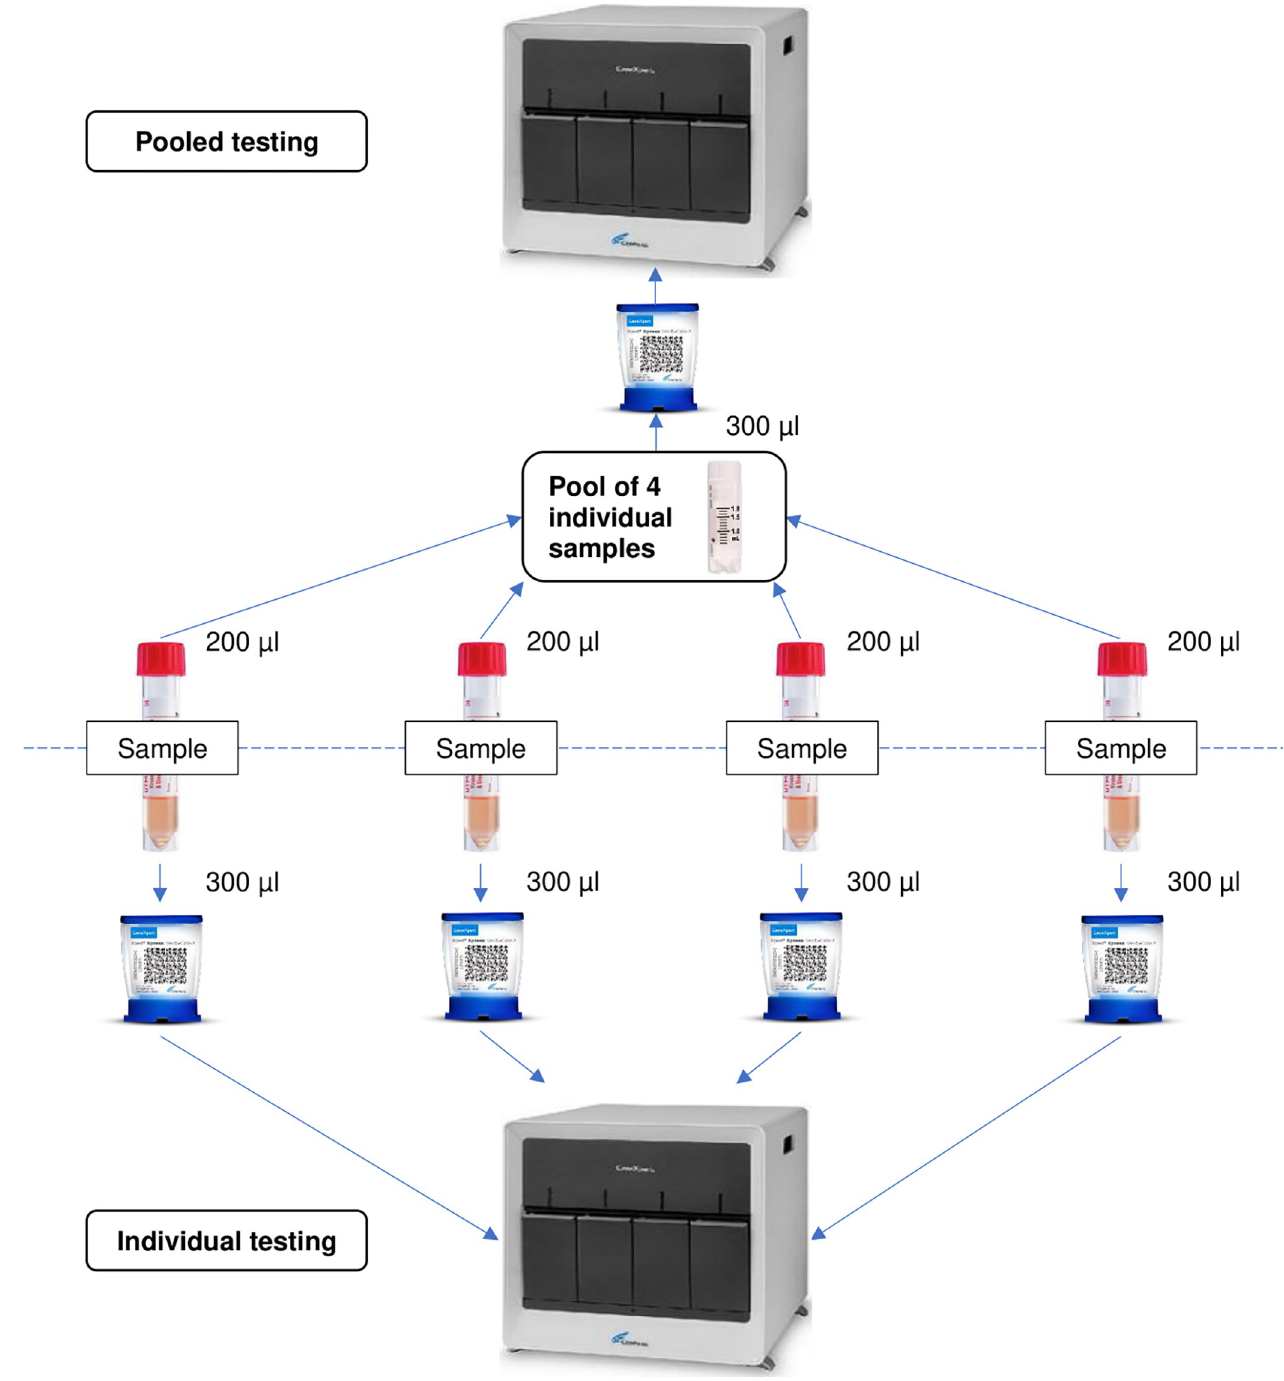
Fig 1. Flow diagram of the sample